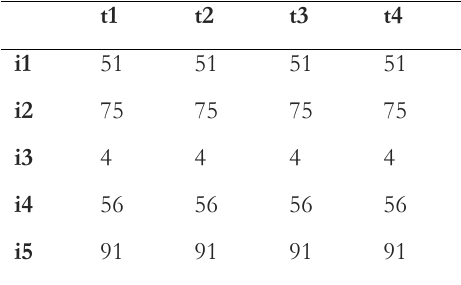
Table 11. Work period